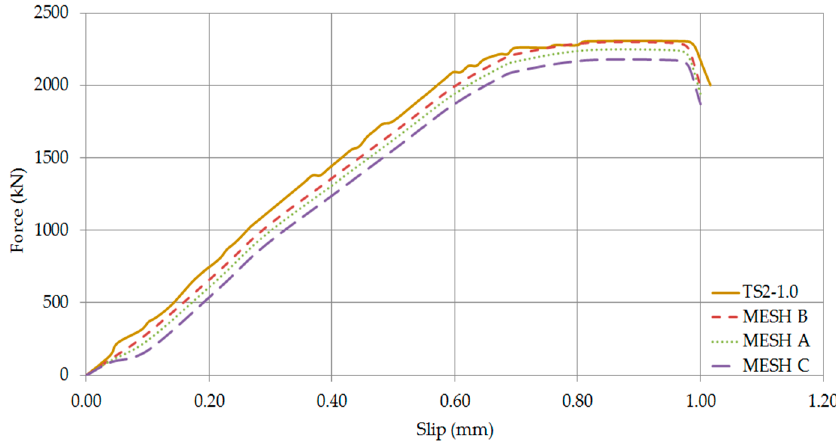
Figure 23. Axial force—Slip Curves of TS2-1.0 (Comparison of mesh densities).